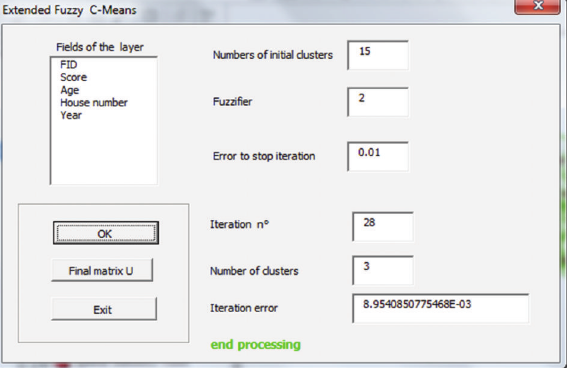
Figure 2: Example of events georeferenced on a road network.